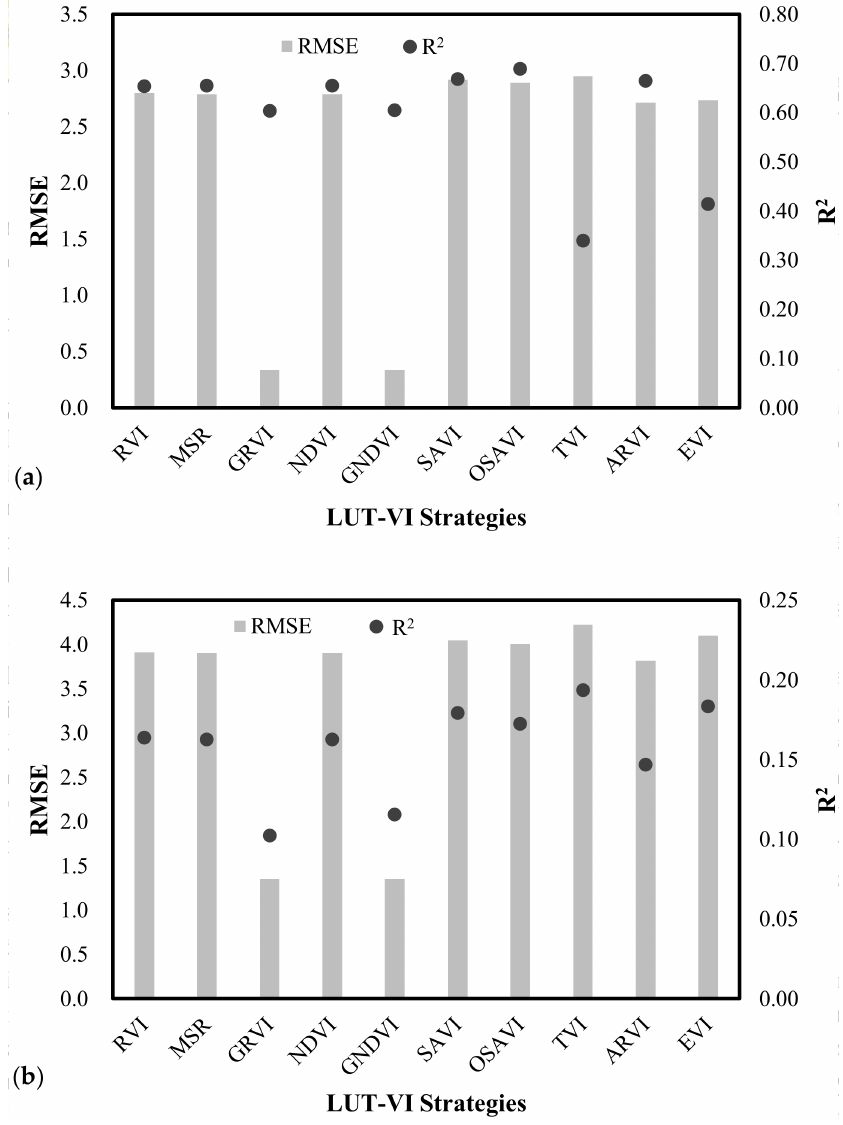
Figure 5. Performances of LAI-LUT strategies with different VIs to estimate the LAI based on the GF-1 data on 14 April ( a ) and at 25 May ( b